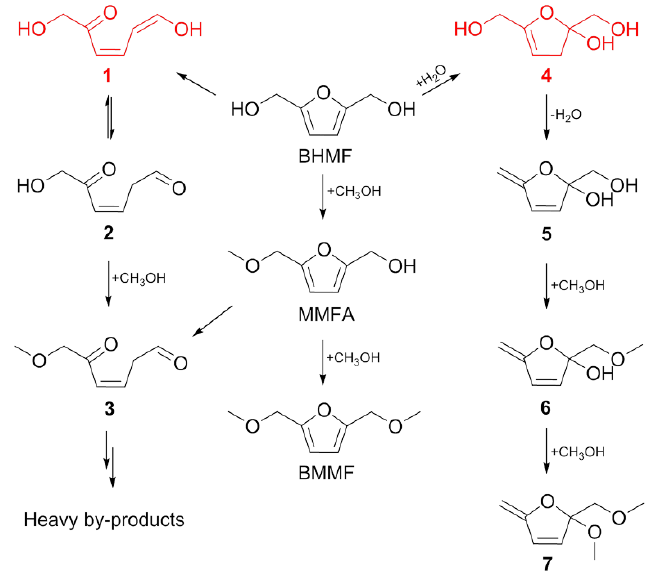
Scheme 1. Proposed mechanism of by-products formation during the BHMF etherification.